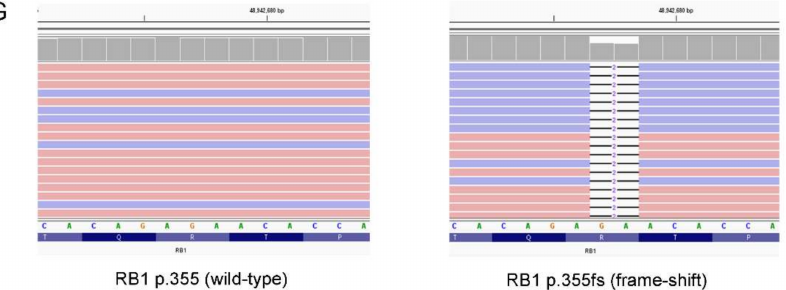
Figure 4. Case 6 was a 32-year-old woman with gastrointestinal stromal tumor (GIST) that displayed a sheet-like growth pattern with extensive hyalinization ( A ), composed of spindle cells ( B ) and uniform epithelioid cells ( C ) with the former arranged in a pattern analogous to Verocay bodies. Myxoid changes ( D ) were present in some areas. The most recent biopsy (108 months after the initial diagnosis) showed a recurrent GIST with epithelioid morphology ( E ) with diffuse c-KIT expression ( F ). Next-generation sequencing revealed a pathogenic RB1 p.R355fs mutation ( G , right) in the most recent biopsy specimen but not in the primary ( G , left) or previous recurrent tumors.